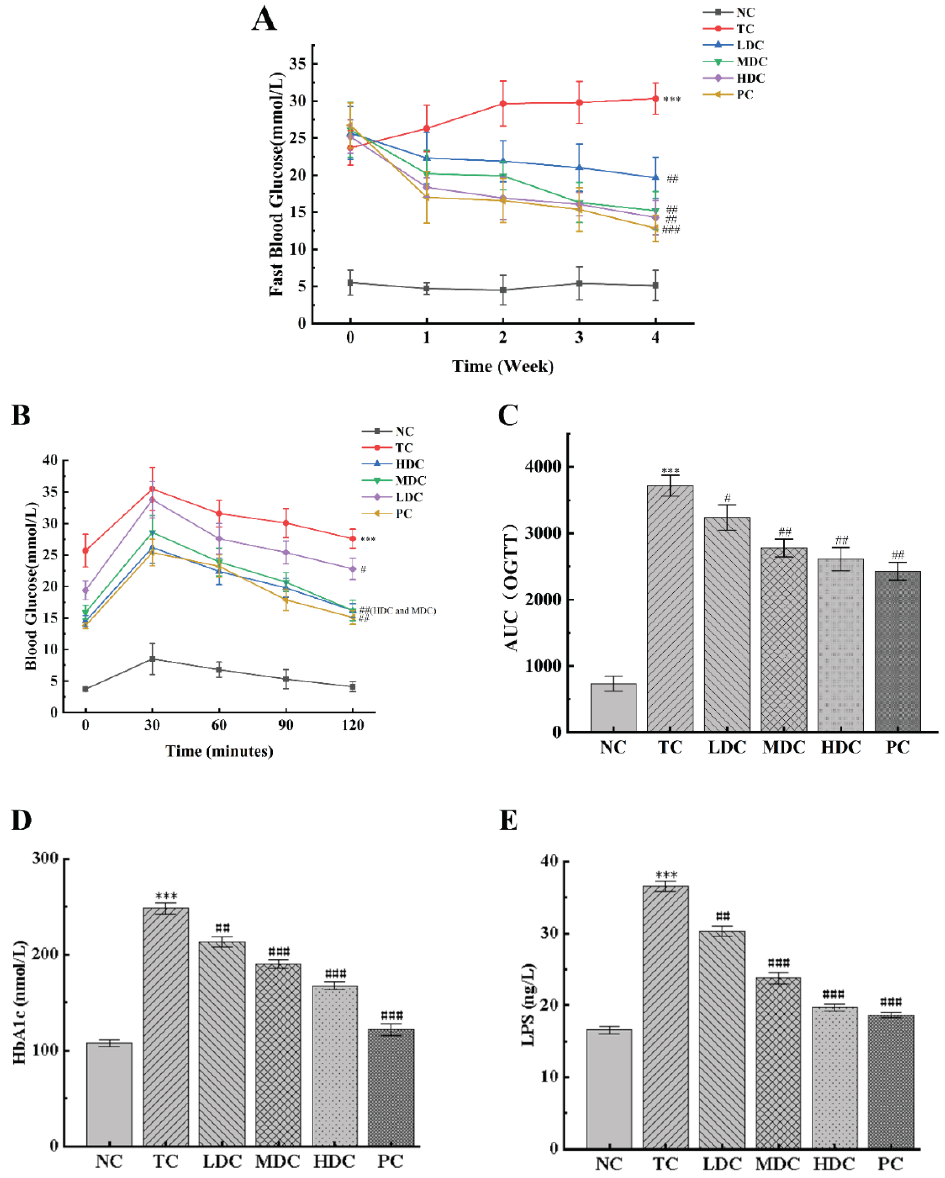
Figure 3. Effect of PSS on glucose tolerance in mice. ( A ) Fasting blood glucose. ( B ) Oral glucose tolerance test (OGTT) experiment results. ( C ) The area under the curve (AUC) of OGTT. The contents of ( D ) glycosylated hemoglobin (HbA1c). The contents of ( E ) serum lipopolysaccharides (LPS). Data are presented as mean ± SD (n = 8); *** p < 0.001 compared to the NC group; # p < 0.05, ## p < 0.01, and ### p < 0.001 compared to the TC group.